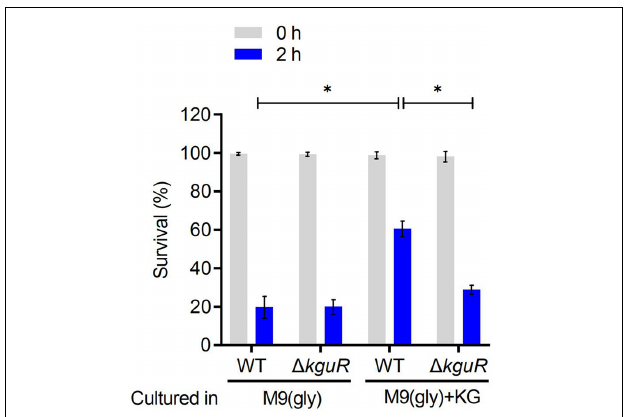
FIGURE 3 | KguR promotes acid resistance of UPEC. Bacteria were grown anaerobically in M9(gly) in the absence or presence of KG to stationary phase, and then the cultures were diluted into acidic LB (pH 2.5) for 2 h acid treatment. Viable counts were measured at time 0 and 2 h after acid challenge. Survival = (CFU 2 h /CFU 0 h ) × 100%. The data shown are the means ± SEM from three independent experiments. ∗ P <